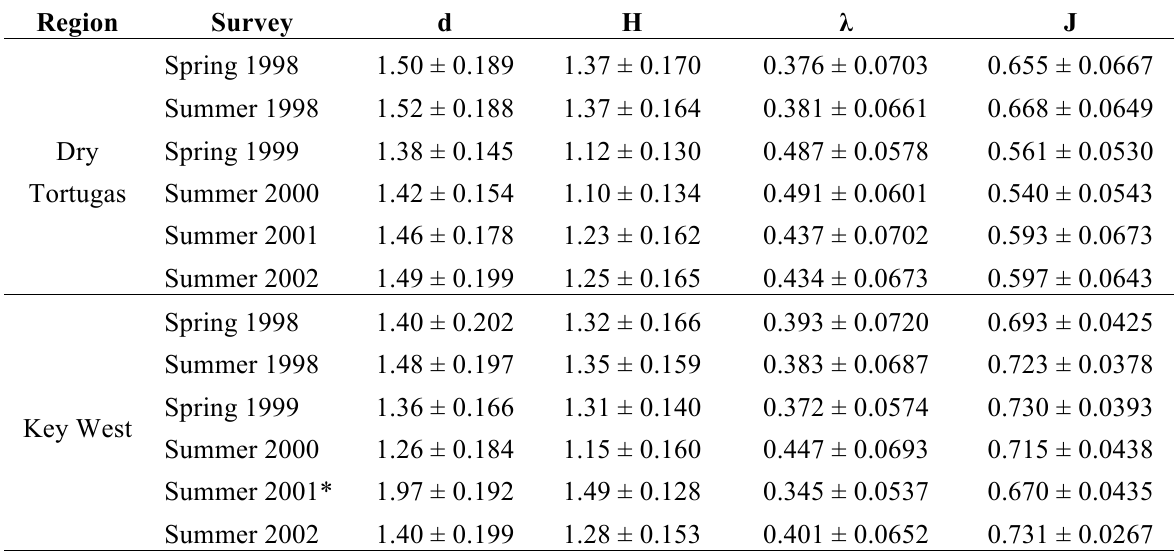
Table 1. Mean diversity indices (±SE) of coral communities in Key West and the Dry Tortugas: Margelef’s species richness (d), Shannon’s species diversity (H), Simpson’s dominance ( λ ) and Pielou’s species evenness